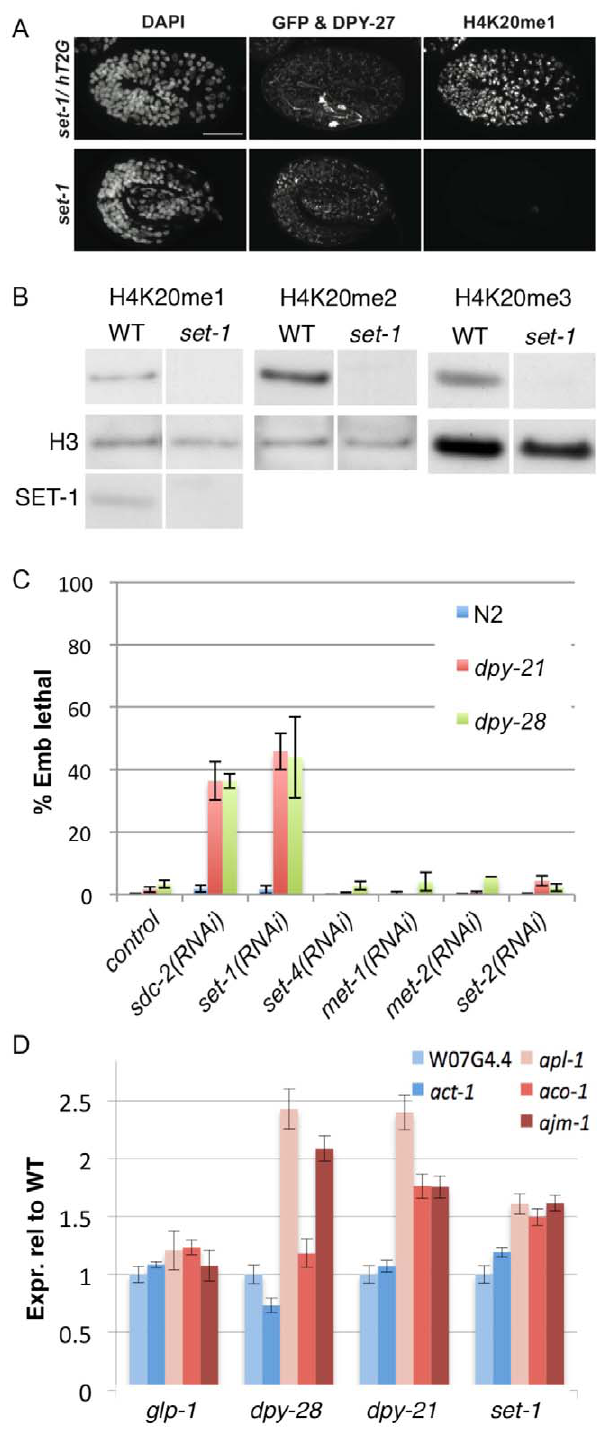
Figure 5. The H4K20me1 methyltransferase SET-1 genetically interacts with dosage compensation mutants and is required for repression of X-linked gene expression. (A) Embryos were stained with DAPI and antibodies to DPY-27 and H4K20me1. In set-1/ hT2G embryos (identified by pharyngeal GFP signal from the hT2G balancer chromosome), DPY-27 and H4K20me1 are enriched on the X chromosome. In homozygous set-1 mutant embryos, DPY-27 is enriched on the X, but H4K20me1 is undetectable. Scale bar represents 10 um. (B) Western blots of H4K20me1, H4K20me2, and H4K20me3 in wild-type (WT) and set-1(tm1821) mutant adults. The loading control is histone